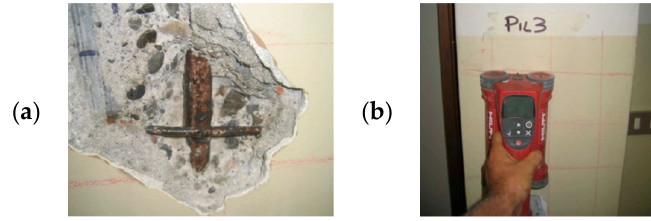
Figure 6. Images of a concrete cover demolition ( a ) and a pacometer test ( b ).